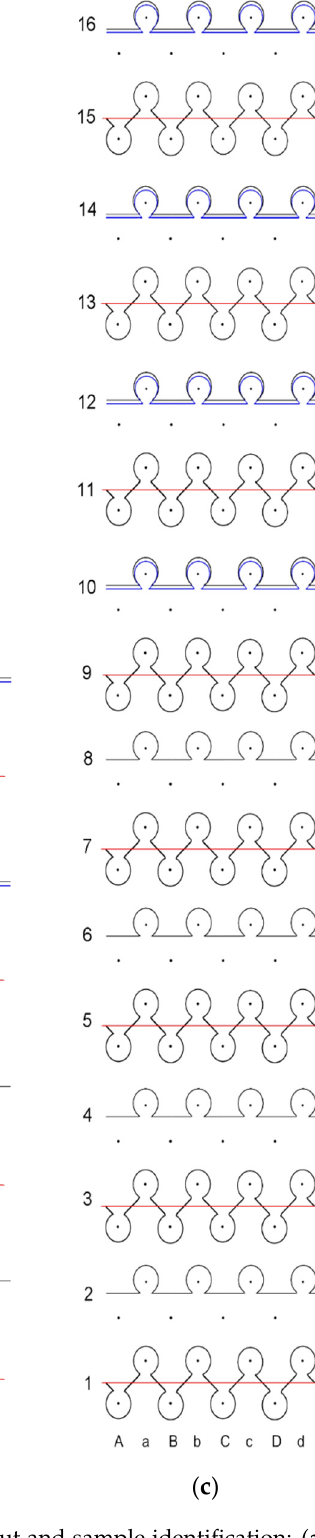
Figure 1. Principle scheme of conductive yarn layout and sample identification: ( a ) CF_LY1 and CF_HY1; ( b ) CF_LY2 and CF_HY2; and ( c ) CF_LY3 and CF_HY3. ( PA6.6 ground yarn, PA + Ag conductive yarn (66 tex for CF_LY and 235 tex for CF_HY), Elastomeric inlay yarn).